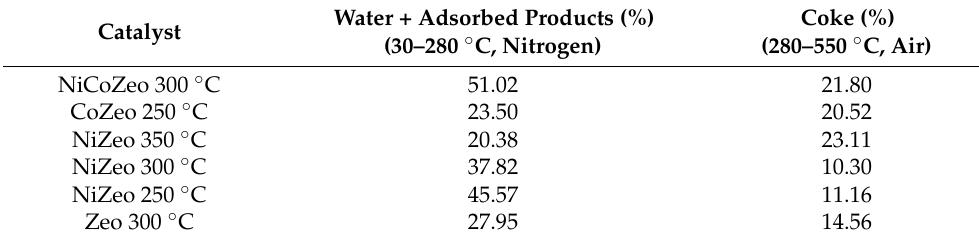
Table 3. Thermal analysis of recycled